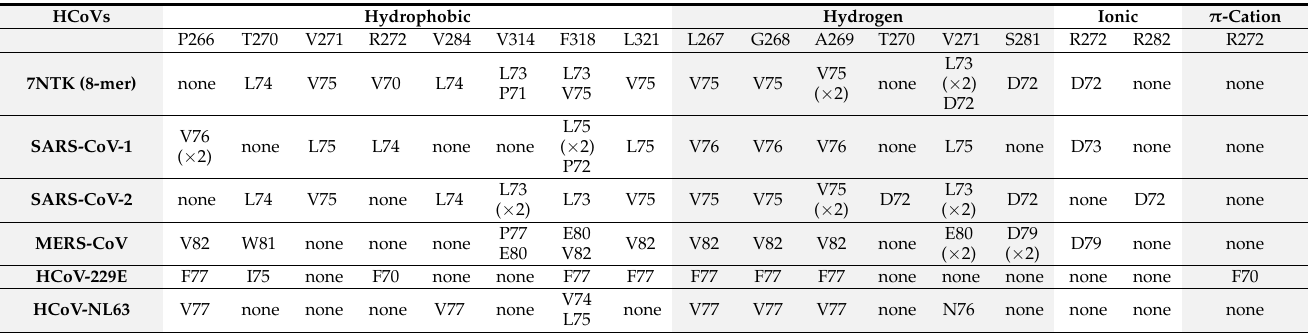
stick, blue) (PDB ID: 7NTK). ( B ) Stick model of the modelled SARS-CoV-1 (8-mer) E peptide (gold) docked to the PDZ domain of the PALS1 protein (blue). ( C ) Stick model of the modelled SARS-CoV-1 (18-mer) E peptide (gold) docked to the PDZ domain of the PALS1 protein (blue). ( D ) Stick model of the modelled SARS-CoV-2 (8-mer) E peptide (gold) docked to the PDZ domain of the PALS1 protein (blue). ( E ) Stick model of the modelled SARS-CoV-2 (18-mer) E peptide (gold) docked to the PDZ domain of the PALS1 protein (blue). ( F ) Stick model of the modelled MERS-CoV (8-mer) E peptide (gold) docked to the PDZ domain of the PALS1 protein (blue). ( G ) Stick model of the modelled MERS- CoV (18-mer) E peptide (gold) docked to the PDZ domain of the PALS1 protein (blue). Peptides in B-G were produced from the homology-modelled E proteins of the respective hCoVs and docked to the PDZ domain of the PALS1 protein (PDB ID: 7NTK) using the HADDOCK 2.4 webserver. Docked E peptides with the lowest RMSD values compared with the 7NTK experimental E peptide were uploaded to the protein–ligand interaction profiler (PLiP) webserver to demonstrate the types of interactions between PALS1 and the E peptides. Red, dashed lines: hydrophobic interactions; Cyan, solid lines: hydrogen bonds; Yellow, dashed lines: ionic interactions (salt bridges). Table 1. Types of interactions that occurred between the docked 8-mer hCoV E peptides and the PDZ domain of the PALS1 protein. The PALS1 PDZ domain residues to which the docked hCoV E peptides bound are shown at the top (second row) along with the corresponding PBM residue(s) of each docked hCoV E peptide. Residues are grouped according to the type of interaction that is formed between